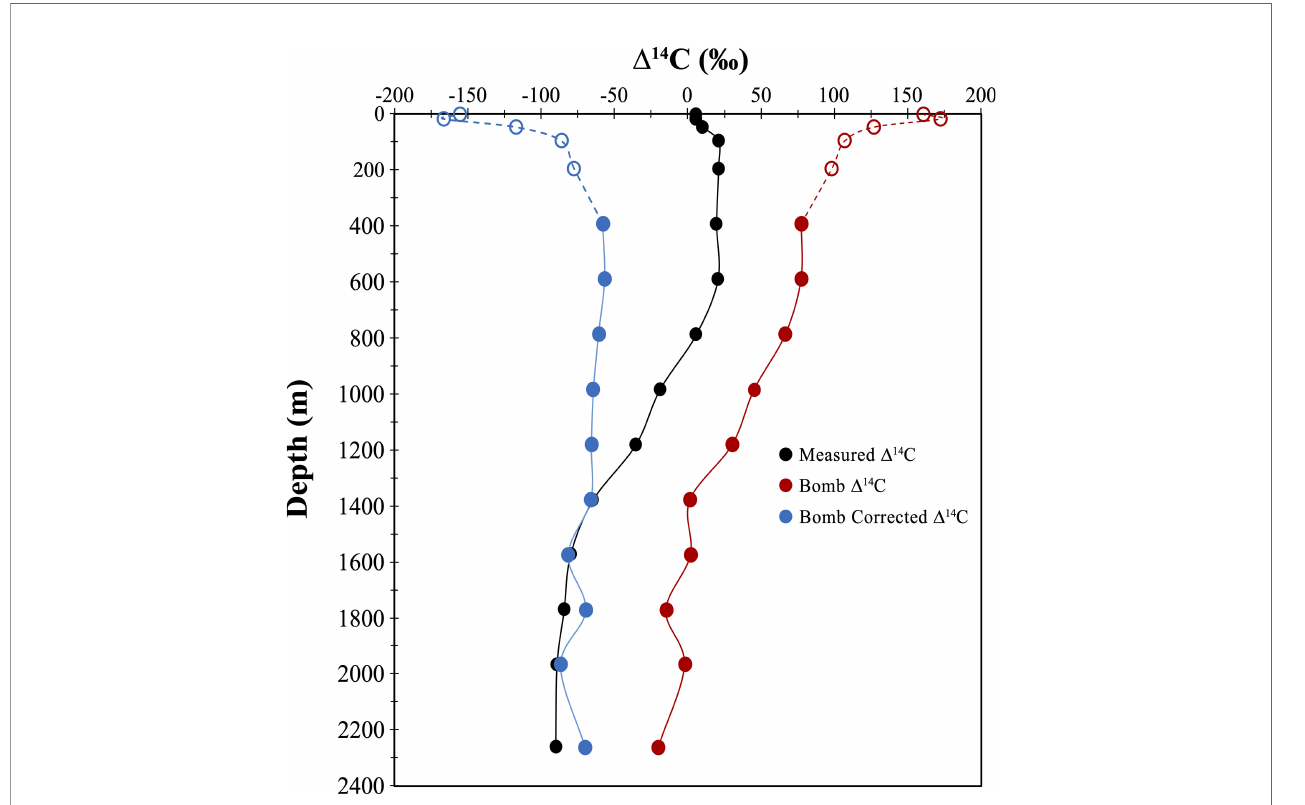
FIGURE 4 | Calculated bomb D 14 C and natural D 14 C values for Baf fi n Bay deep water. Measured DIC D 14 C values for deepest station collected in Baf fi n Bay, BB2 ( Figure 1 ). Calculated D 14 C bomb and D 14 C bomb corr values derived using the Potential Alkalinity (P alk ) method (Rubin and Key, 2002) method ( see Estimation of Anthropogenic (DIC anth ) and “ Bomb ” DIC 14 C ). Dashed lines and open circle indicate overestimated bomb and underestimated natural D 14 C values above